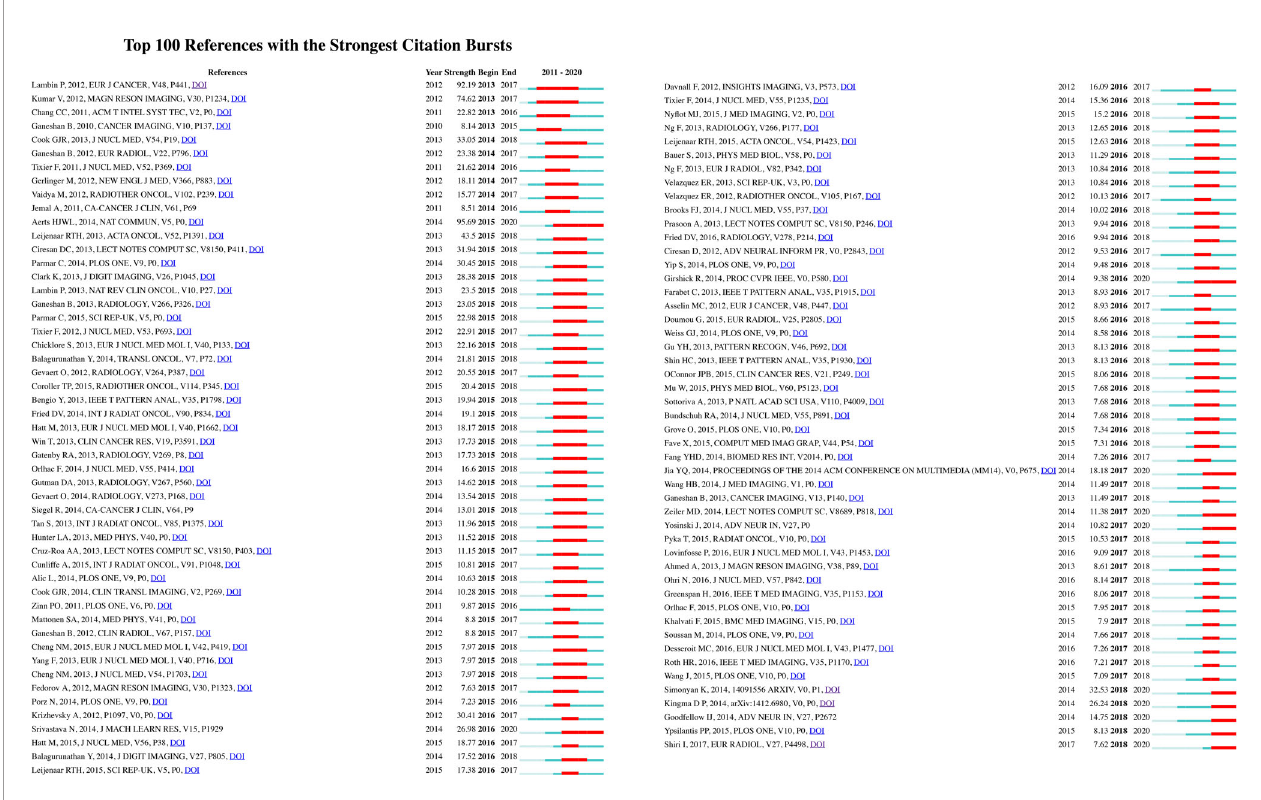
FIGURE 6 | Detection of top 100 references with the strongest citation bursts.